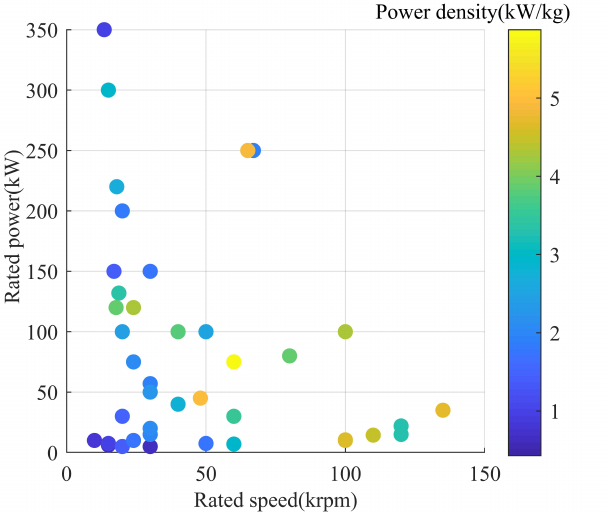
Figure 2. Distribution of power density of high-speed PM motors at different speed and